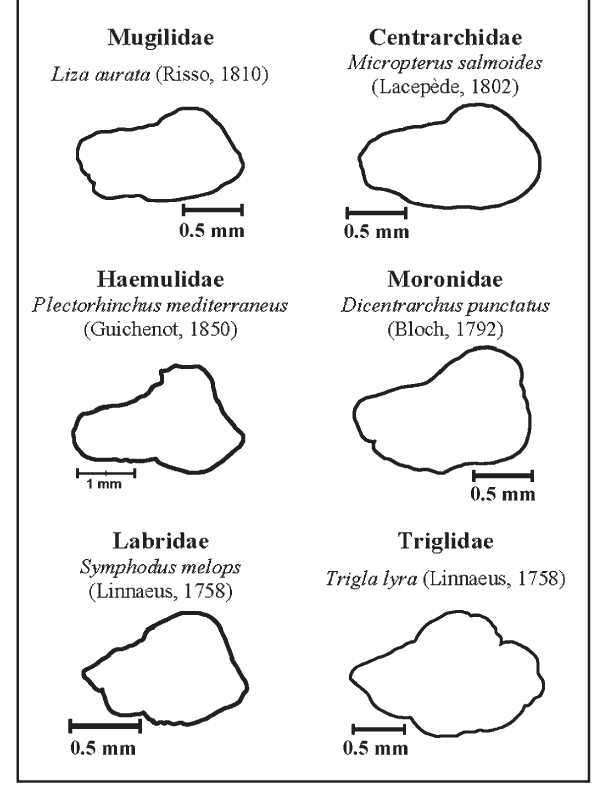
F IG . 9. – Outline of the right lapilli of several species, illustrating the occurrence of otoliths with similar appearance in rather unrelat- ed fish taxa. All outlines are represented with lateral margin to the top of the page and anterior region to the